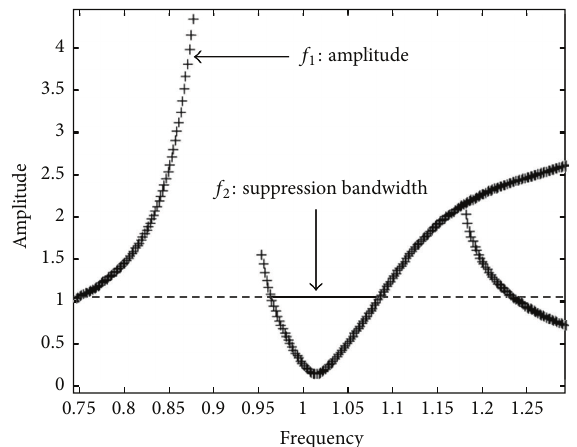
Figure7:ObjectivefunctionsofthenDVAdesignproblem(adapted from